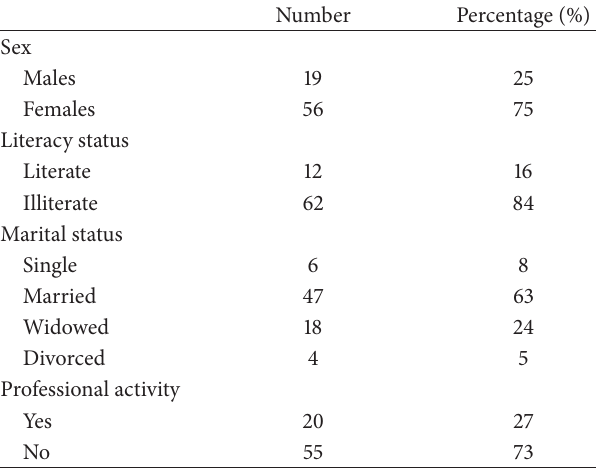
Table 1: Sociodemographic characteristics of study participants. Table2:InternalconsistencyoftheMoroccanSummaryofDiabetes Self-Care Activities measure